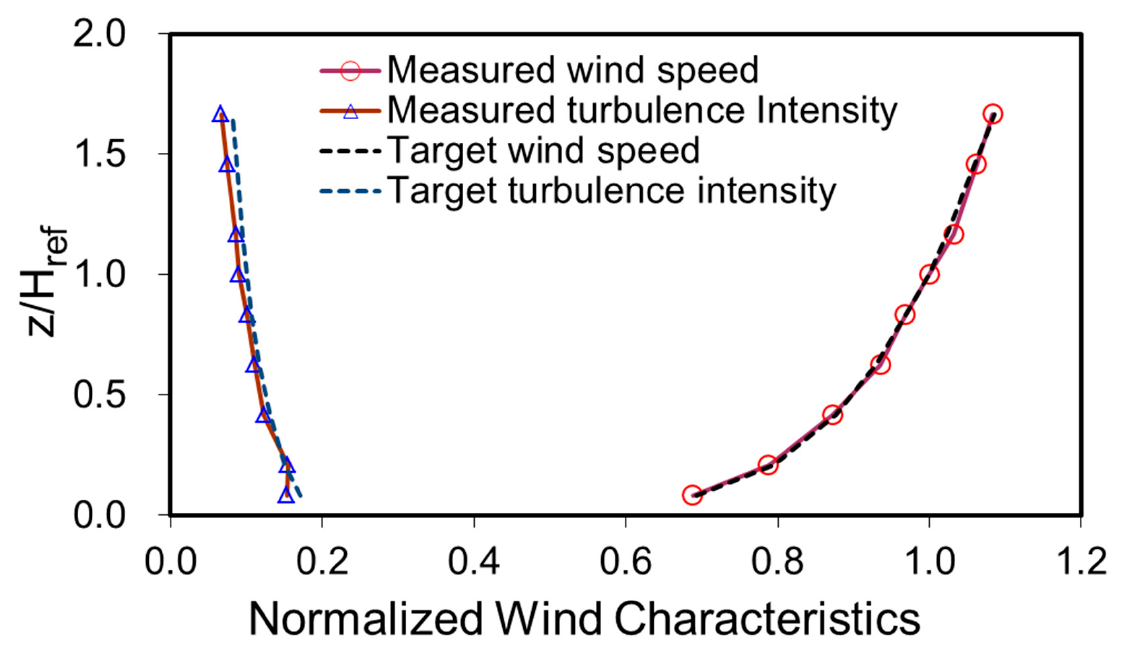
Figure 2. Wind profiles in the wind tunnel. z and H ref represent the heights of the measured position and building top, respectively.